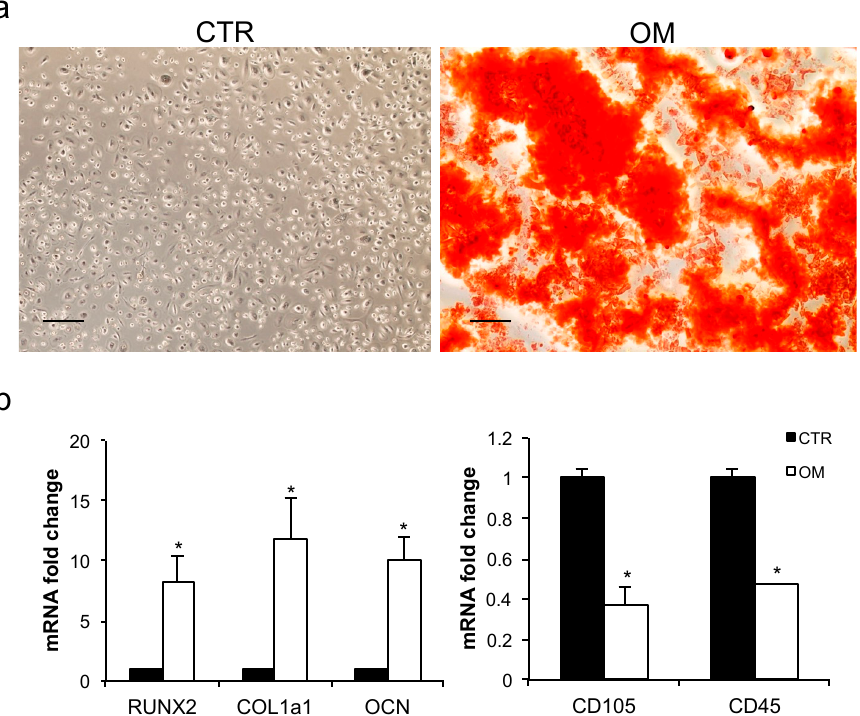
Figure 8. Osteogenic differentiation of CGF primary cells. ( a ) Alizarin Red staining after 21 days in culture medium (Control, CTR) or Osteogenic Medium (OM). Scale bar: 150 µ m. ( b ) mRNA abun- dance of RUNX2, COL1a1, OCN in CGF primary cells cultured in culture medium or OM for 21 days. Gapdh was used as a housekeeping gene for normalization. The fold change in mRNA expression was relative to CTR. The results were expressed as the mean ± SD of triplicate measurements from three independent experiments (* p < 0.05 versus CTR).